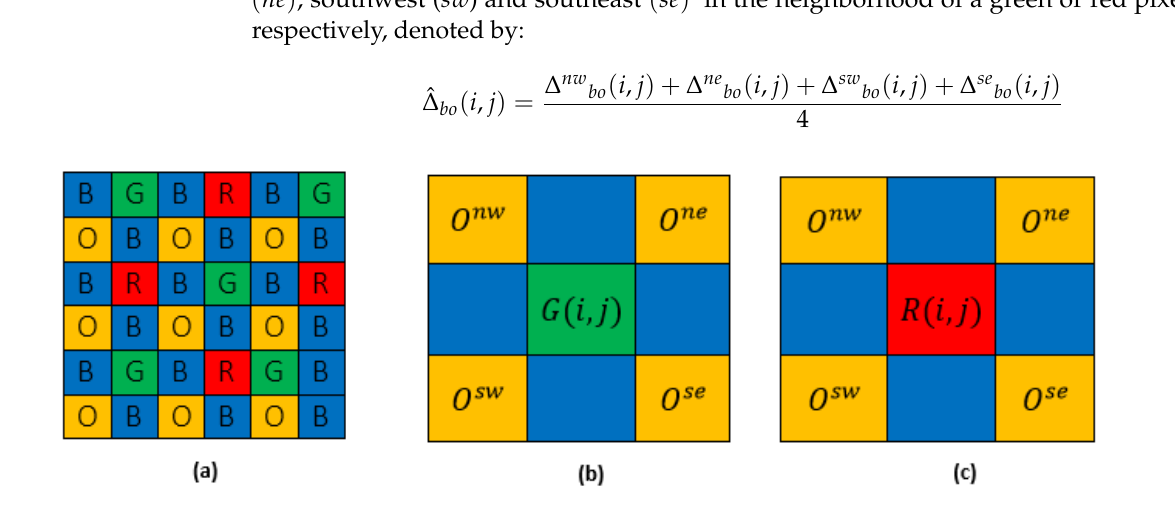
Figure 7. ( a ) Four ‐ band MSFA ( b ) neighborhood of G ‐ band ( c ) neighborhood of R ‐ band. Each orange band is then estimated at the green and red pixels by the formula: